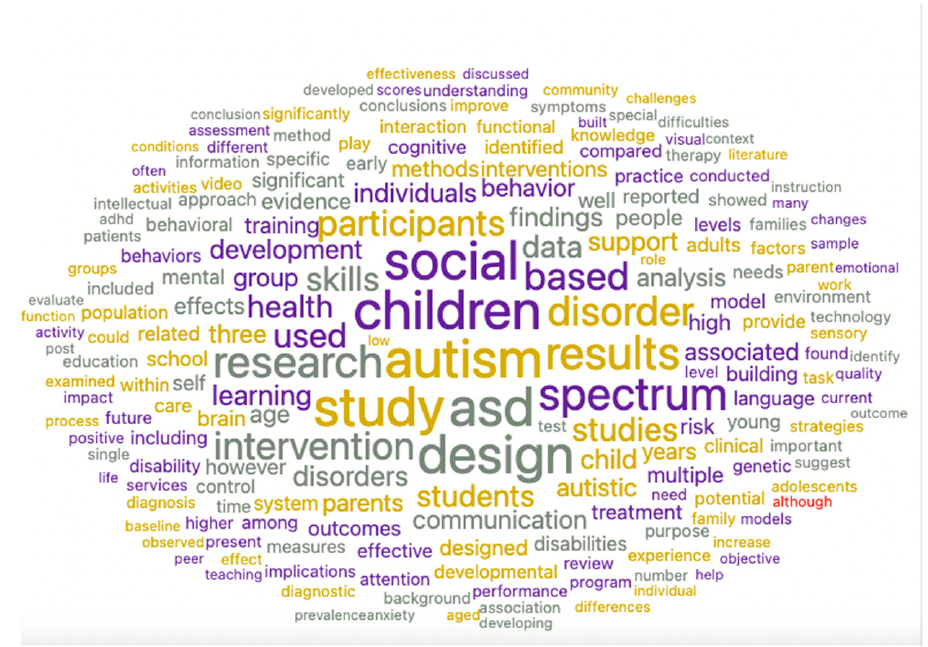
Figure 5. Word cloud distribution of scientific (WoS) documents.